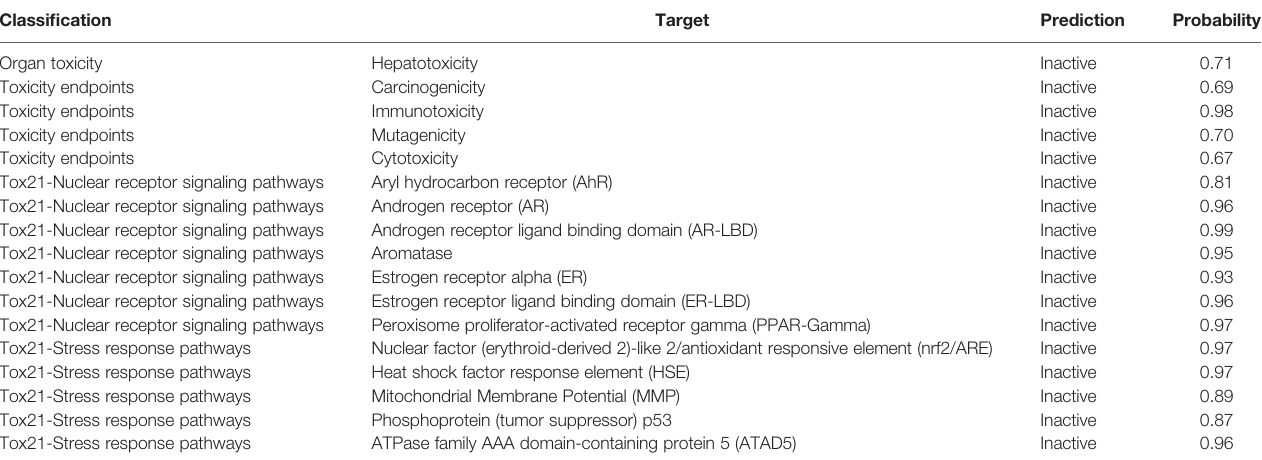
TABLE 4 | Different toxicity pro fi le of QSSM 1157 predicted through ProTox-II server.